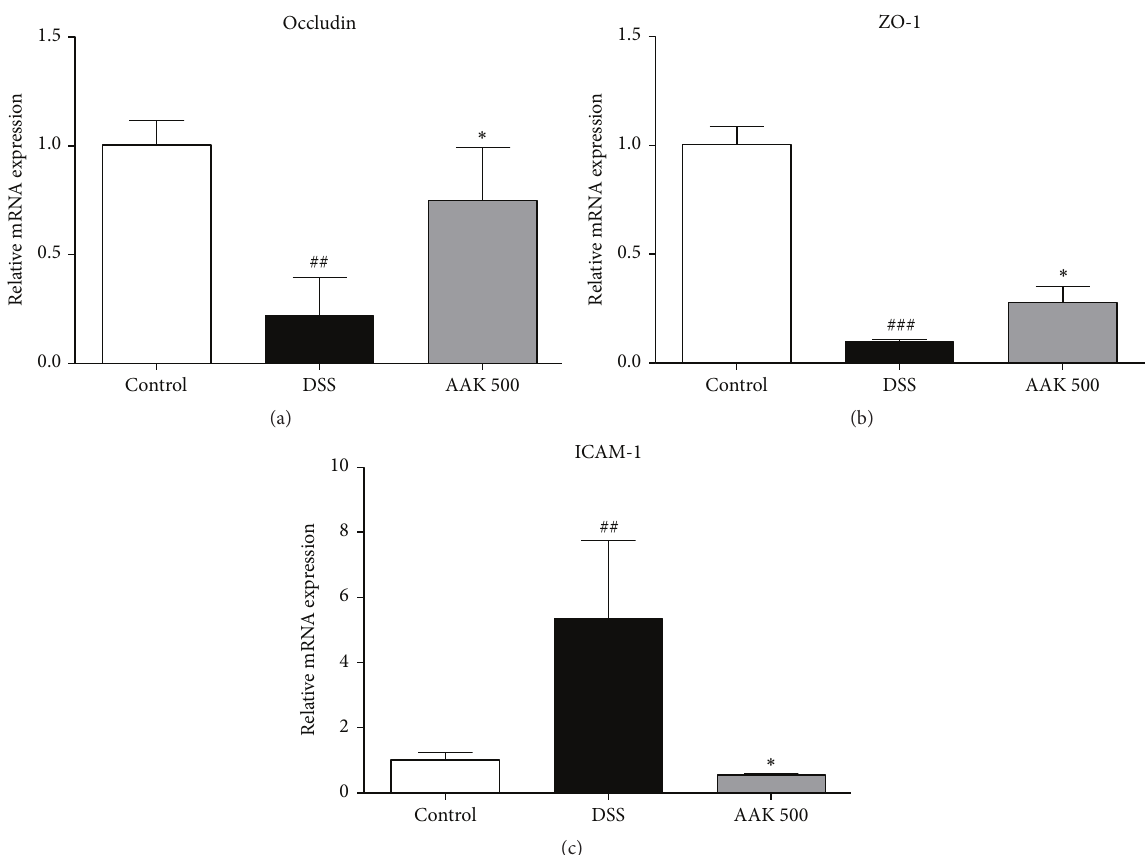
Figure 7: Effects of AAK extract on the gene expression levels of tight junction-related proteins in DSS-induced colitis. (a–c) mRNA expression of occludin, ZO-1, and ICAM-1 was measured by real-time PCR, and GAPDH was used as an endogenous control. Fold-changes are expressed as the mean ± SD ( 𝑛 = 4 – 6 per group). ## 𝑝 < 0.01 and ### 𝑝 < 0.001 versus control; ∗ 𝑝 < 0.05 versus DSS.